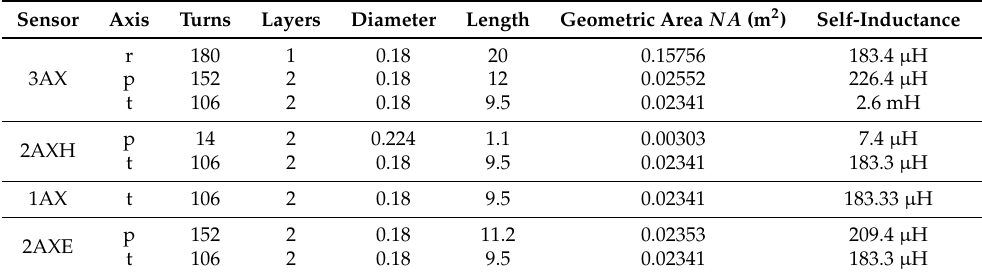
Table 1. Main features of each pick-up coil sensor including the geometric area: the radial, poloidal, and toroidal axes of measurements are denoted as r , p , and t , respectively.